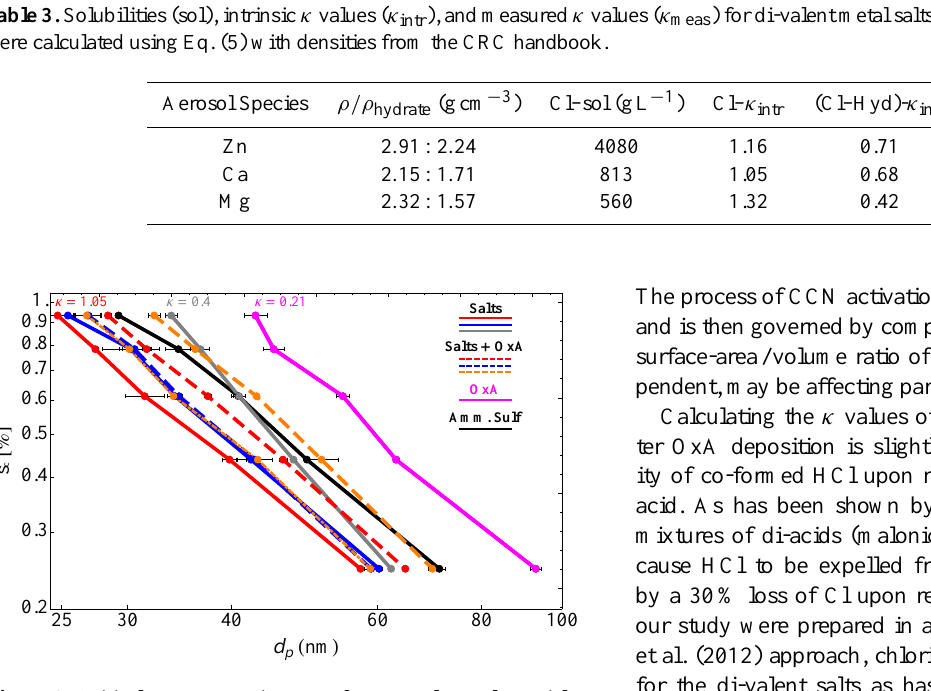
Fig. 2. Critical supersaturation, s c , of monovalent salt particles as a function particle diameter. Results for inorganic salts without OxA deposition are shown by solid lines: NaCl (red), Instant Ocean (blue), Na 2 Ox (grey). The corresponding salts with OxA deposition are dashed lines with the same color. The orange, thick-dashed and thin-dashed lines are for the 1 : 1 and 8 : 1 mixtures of NaCl : MgCl 2 with OxA deposition, respectively. Pure OxA and ammonium sulfate are shown in solid magenta, and black lines, respectively. κ values are shown for NaCl (red), Na 2 Ox (gray), and OxA (magenta).